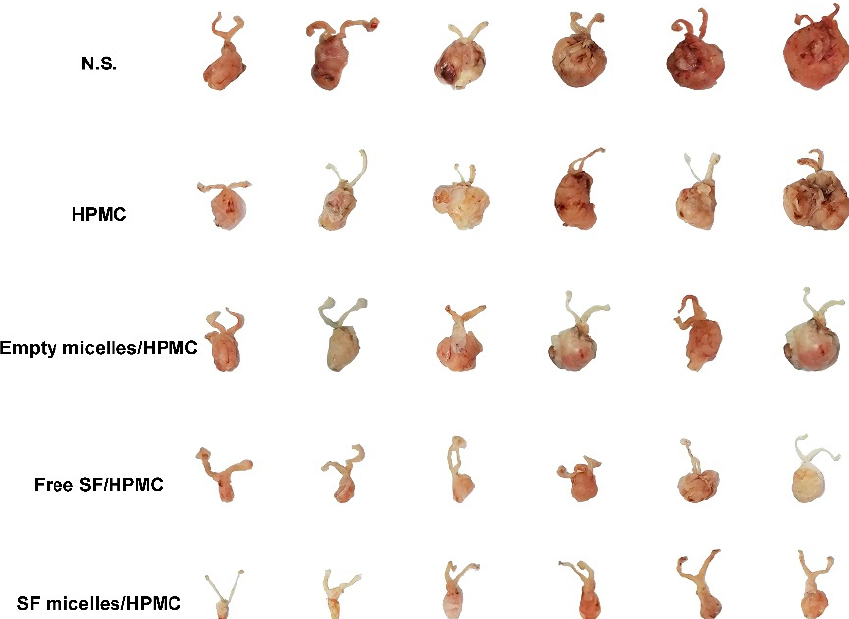
Figure A5. The bioluminescence images of SF micelles/HPMC, Free SF/HPMC, Empty micelles/HPMC, HPMC and N.S. group to the tumor-bearing mice at the day 0, day 4, day 8, day 12 and day16 (n = 6) ( A – E ).